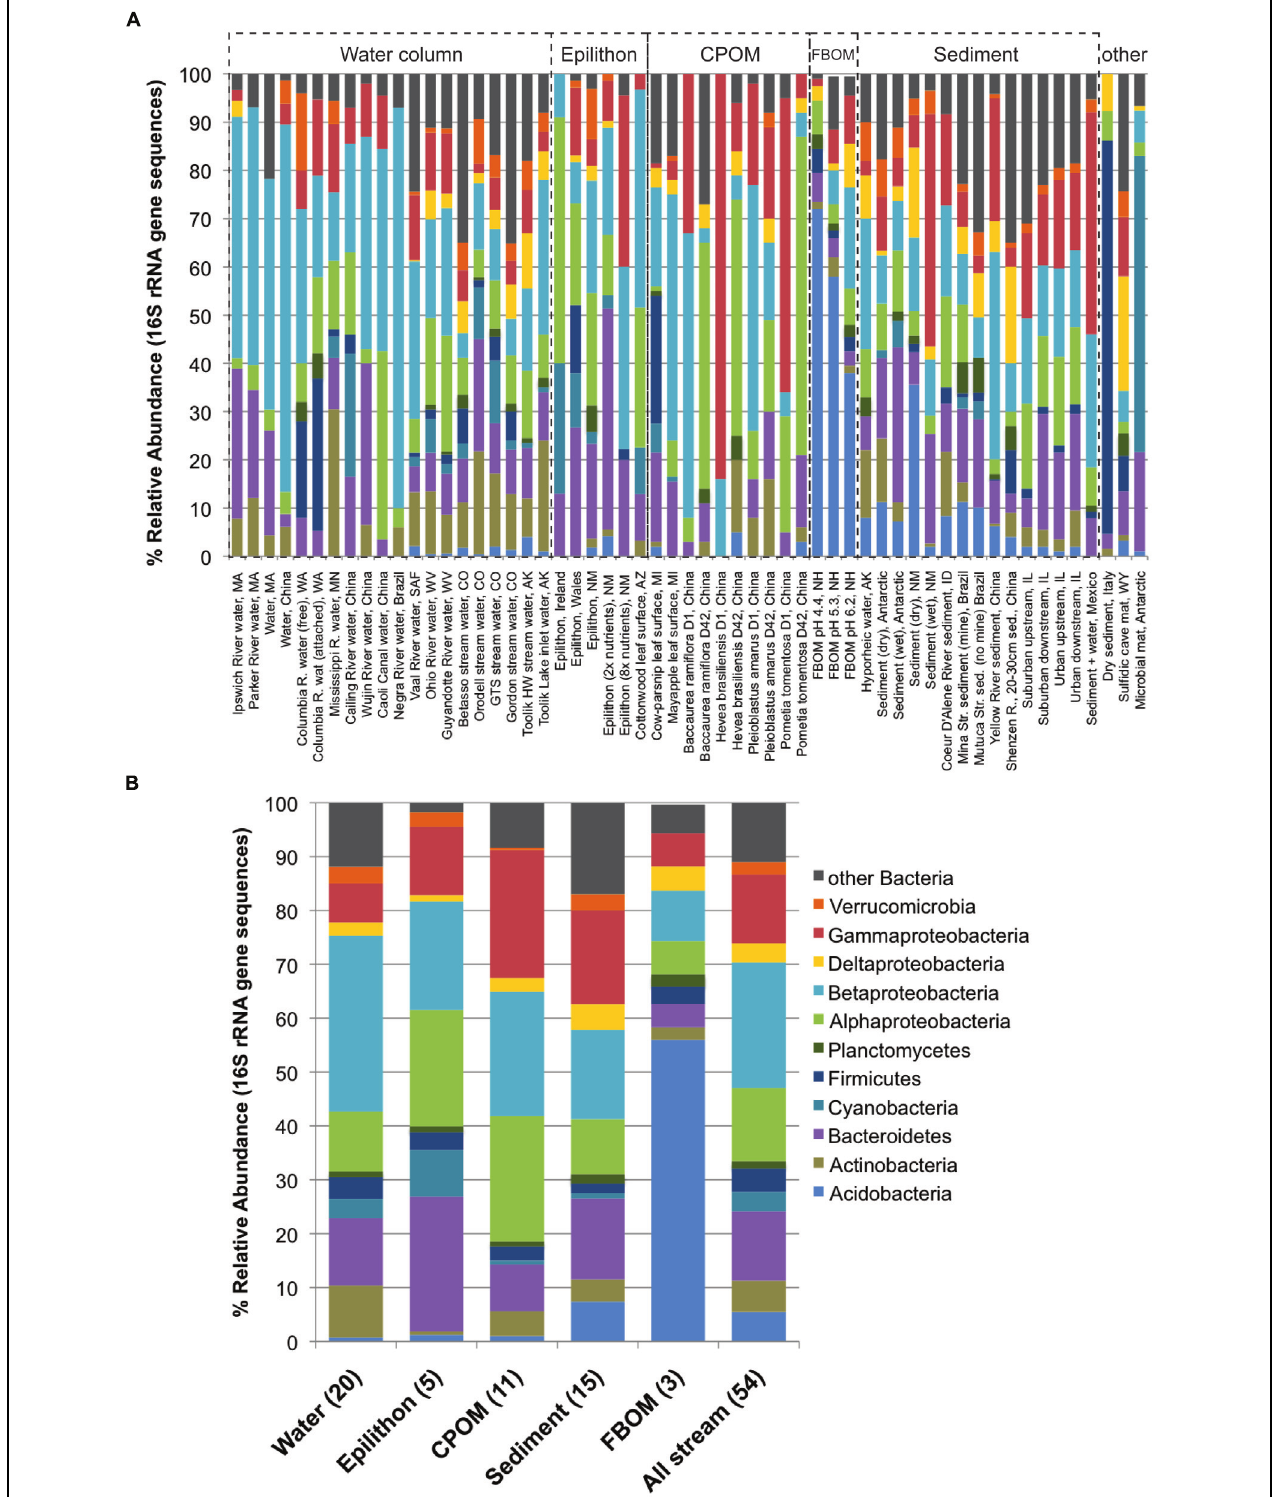
FIGURE 4 | Relative abundance of major bacterial phyla and subphyla (based on 16S rRNA gene sequence libraries, available from 29 papers) for all available defined compartments: (A) all samples with habitats and